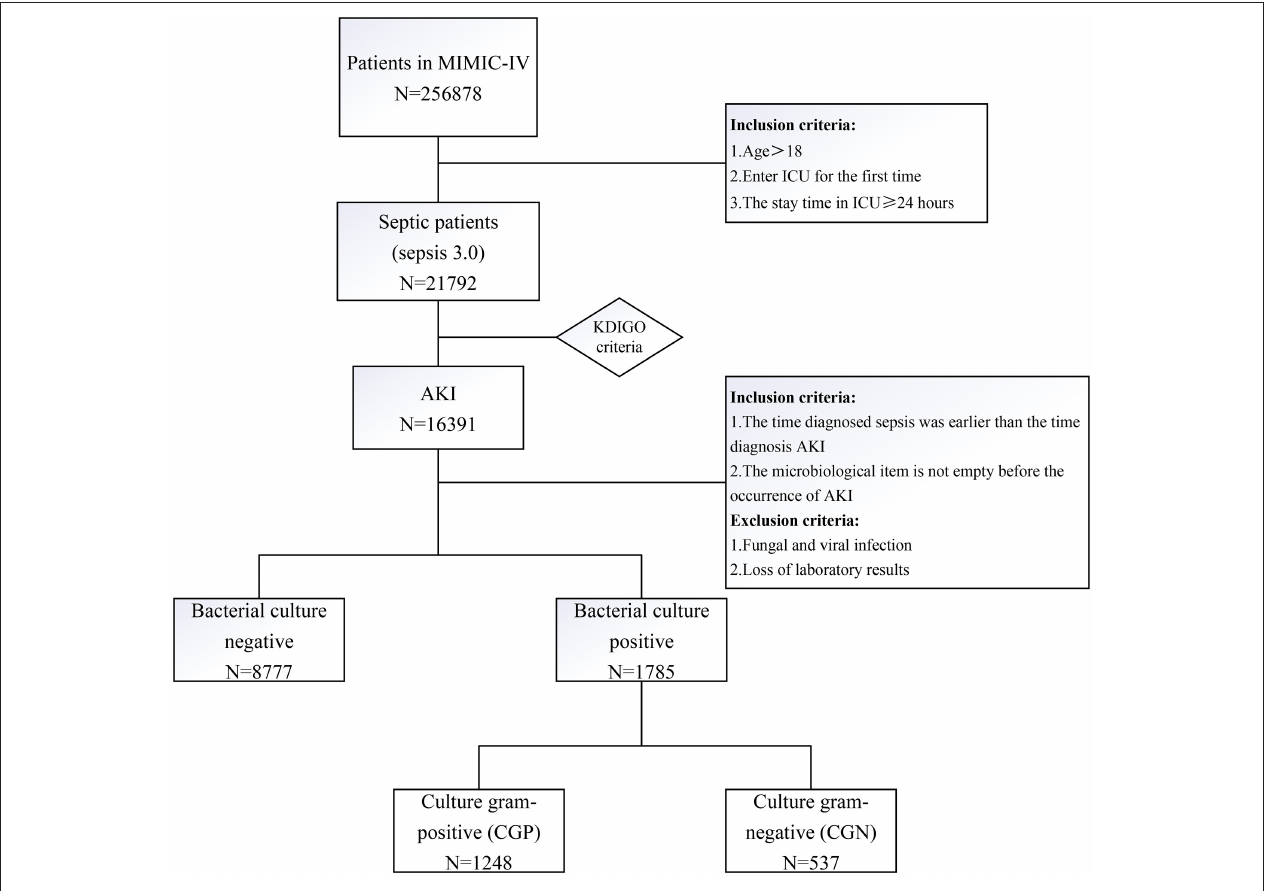
FIGURE 1 | The flowchart of the study population. Data were retrieved from the MIMIC database IV. ( Supplementary Table 1 ). Then, 1,785 patients with bacterial culture positive remained and were divided into CGP and